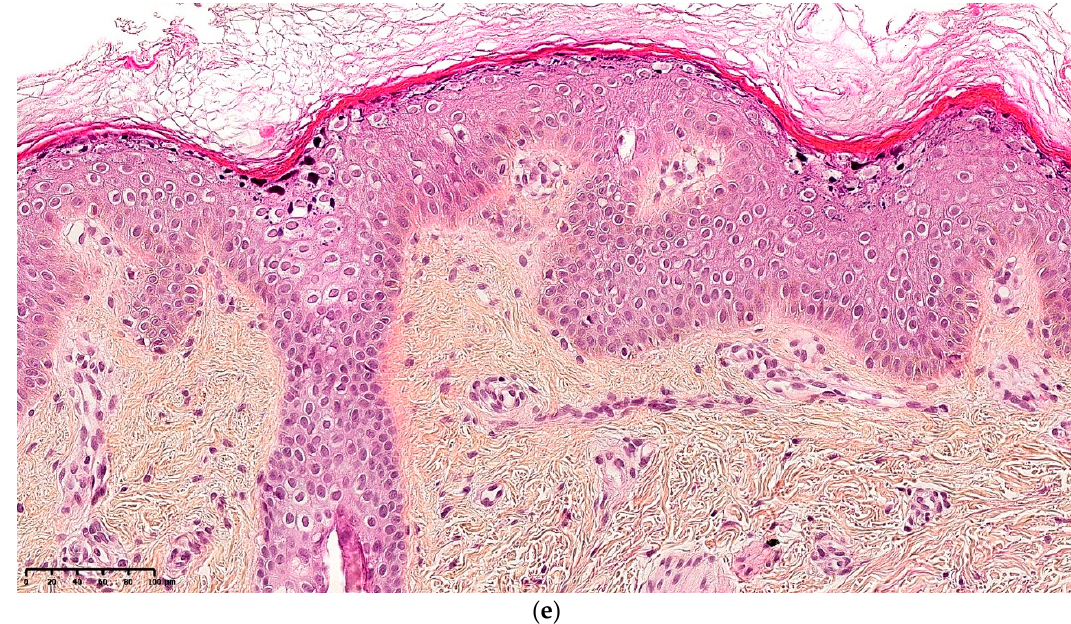
Figure 7. Epidermolytic ichthyosis. ( a ) Newborn with superficial blisters and erythroderma. ( b ) Palmoplantar keratoderma in CK1 mutation. ( c ) Hematein eosin × 10: confluent epidermolysis leading to blister. ( d ) Hematein eosin × 20: epidermolysis with basophilic and eosinophilic granules. ( e ) Hematein eosin × 20: SEI, epidermolysis is located in the granular layer.